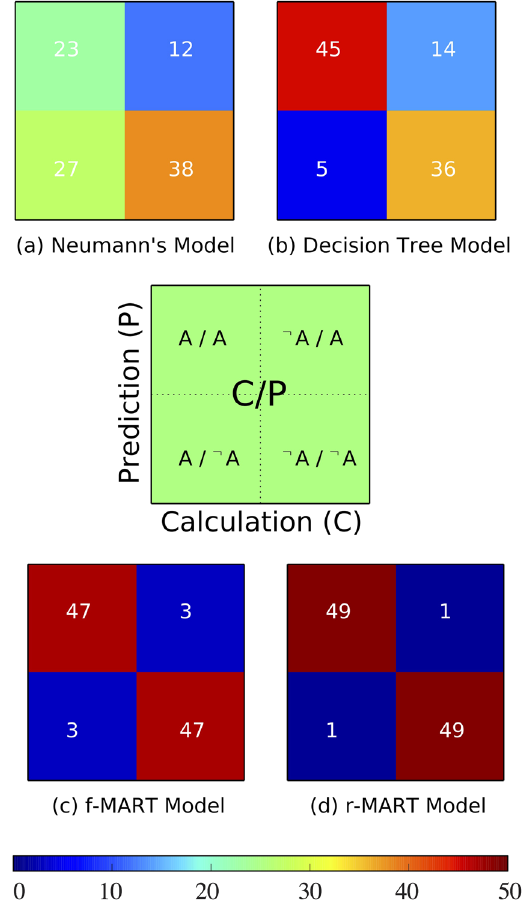
Fig. 2 Confusion matrices of calculated and predicted classi fi cation results for 100 antisite (A) and non-antisite ( ¬ A) type B2 inter- metallics using a Neumann ’ s, b DT, c f-MART, and d r-MART